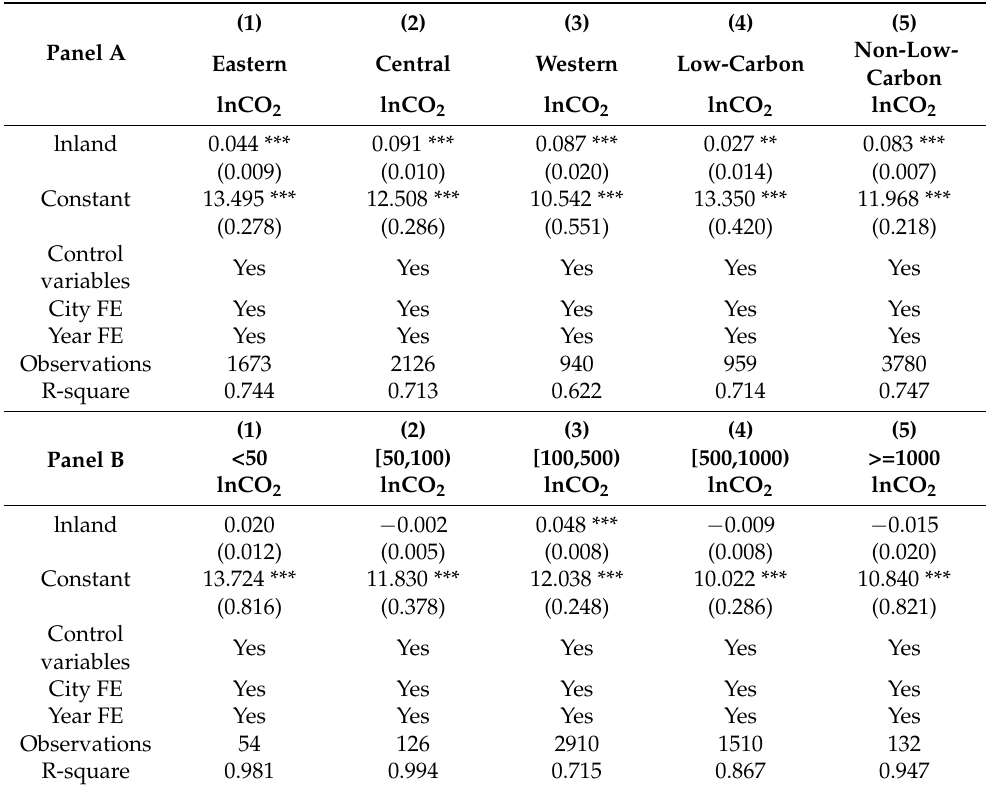
Table 7. The results of heterogeneity